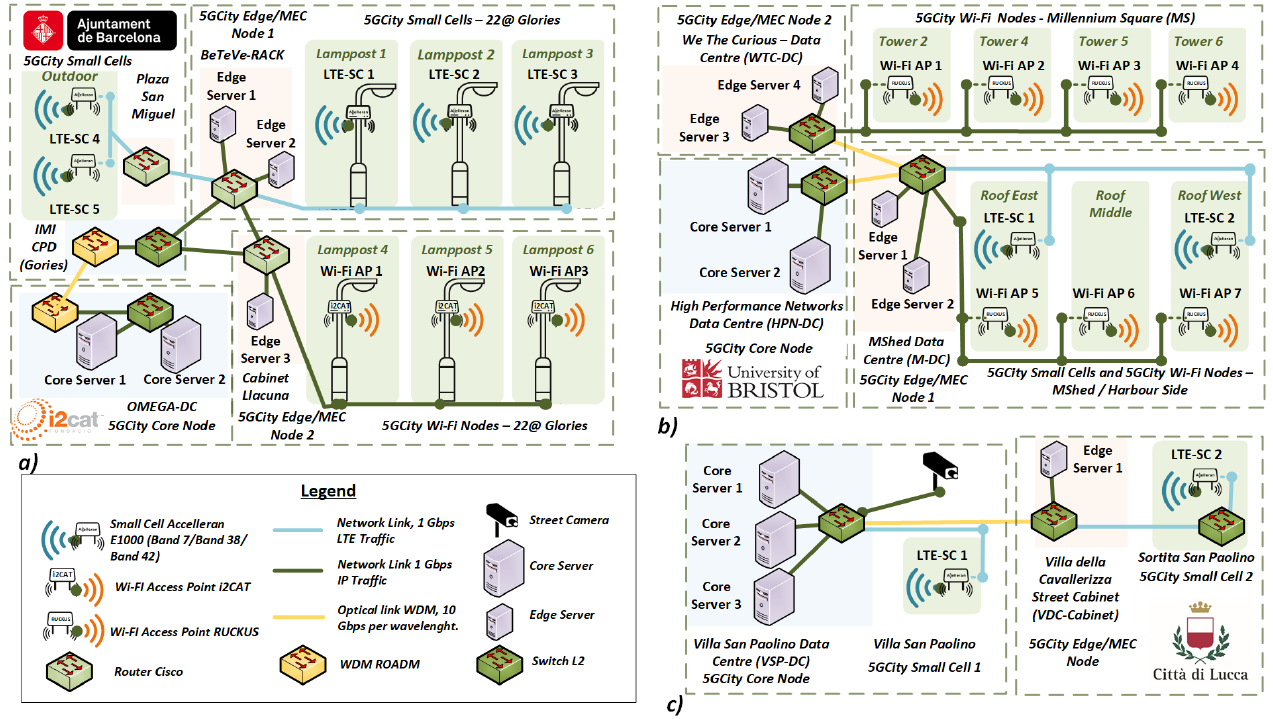
Figure 2. Infrastructure design for ( a ) Barcelona, ( b ) Bristol and ( c )